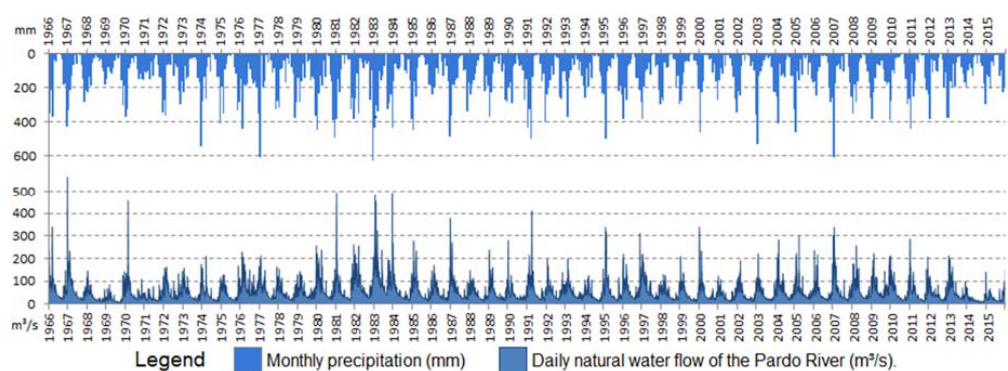
Figure 4. ( a ) 50-year monthly rainfall (1966–2015) with boxplot comparison; ( b ) 1983 and 1984 monthly rainfall.